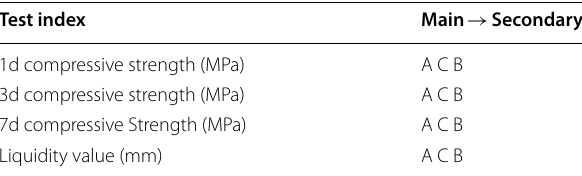
Table 20 Order table of the primary and secondary influences